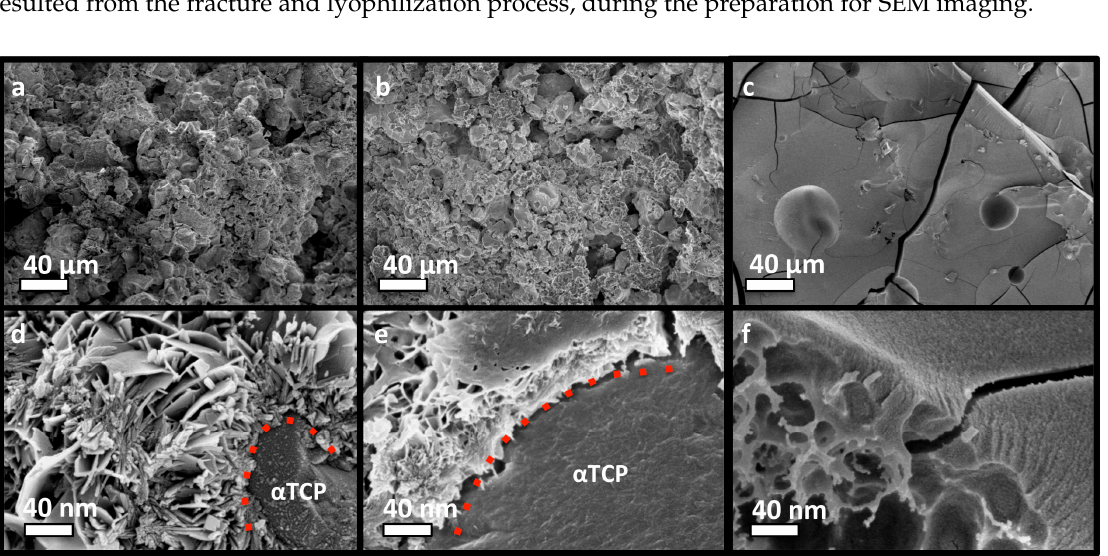
Figure 4. SEM images of the fracture surface of discs made of PM-CPCS. ( a – c ) The microstructure of PM-CPC changed as the mol% of phosphoserine increased from 0% ( a ) to 2% ( b ) to 53% ( c ); shifting from agglomerations of α TCP particles ( a ) to an amorphous solid ( c ). ( d – f ) Higher magnification images (100,000 × ), from 0% ( d ) to 2% ( e ) to 53% ( f )) revealed that phosphoserine formed a thin organic layer that covered the outside of individual α TCP particles, and replaced, or subsumed, the nanohydroxyapatite that would normally have reprecipitated (( d ) vs. ( e )). The fracture surface also revealed that the underlying structure of PM-CPC was porous and organic, while the surface was composed of an amorphous/ organic layer that contains nanoscale mineral ( f ). Scale bar dimensions are indicated for each row; 40 µ m ( a – c ), 40 nm ( d – f ).